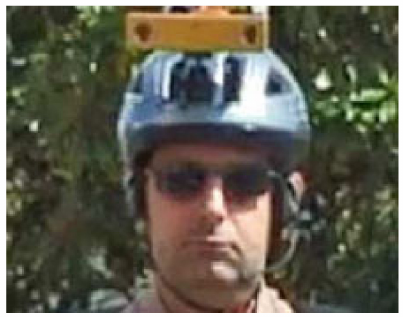
Figure 11. Navig